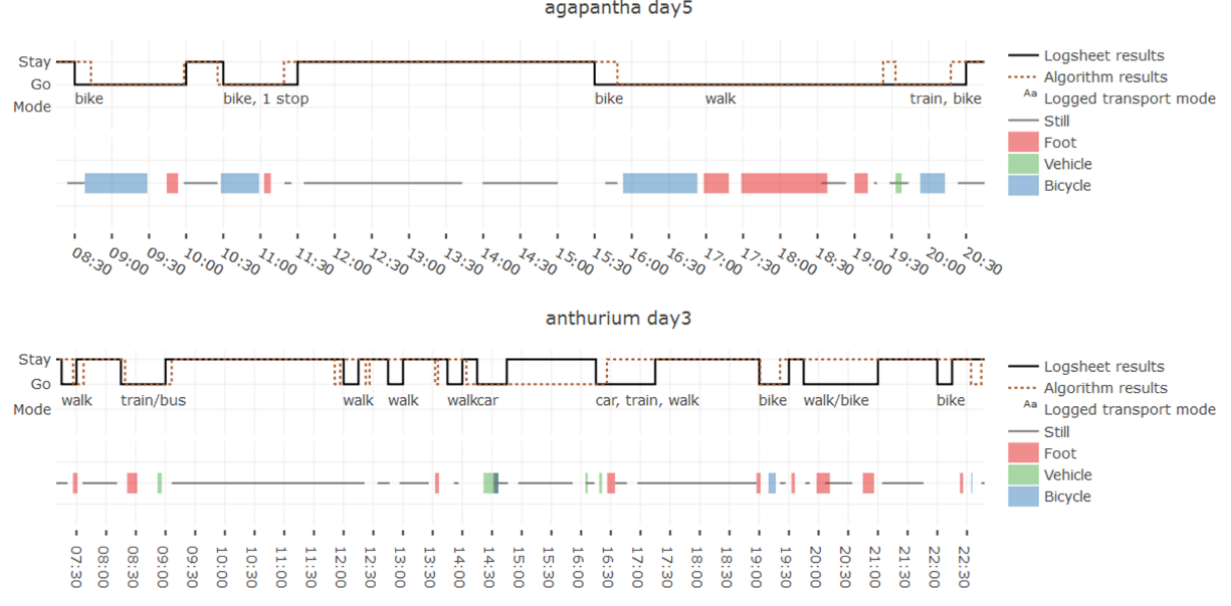
Figure 6. Example time charts for one day from two participants comparing log sheets and algorithm results for trajectory extraction and activity bout